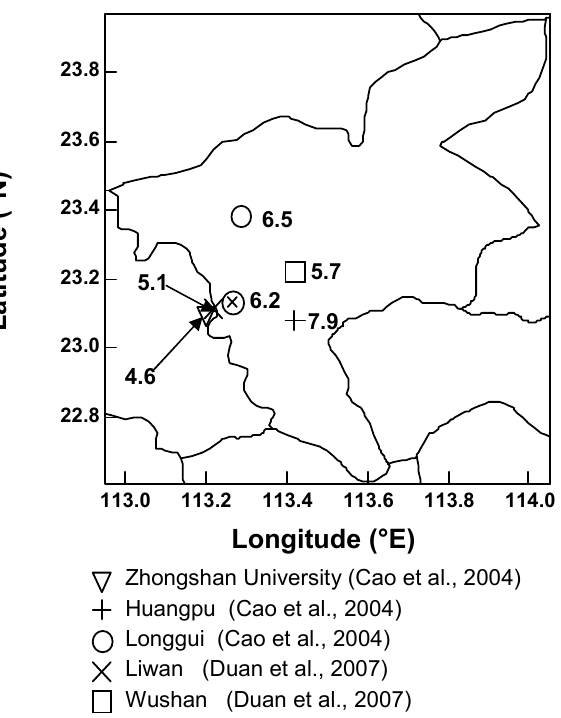
Fig. 10. Comparison of the average BC observed during northerly flows with previous measurements conducted at different sites in Guangzhou in the summer